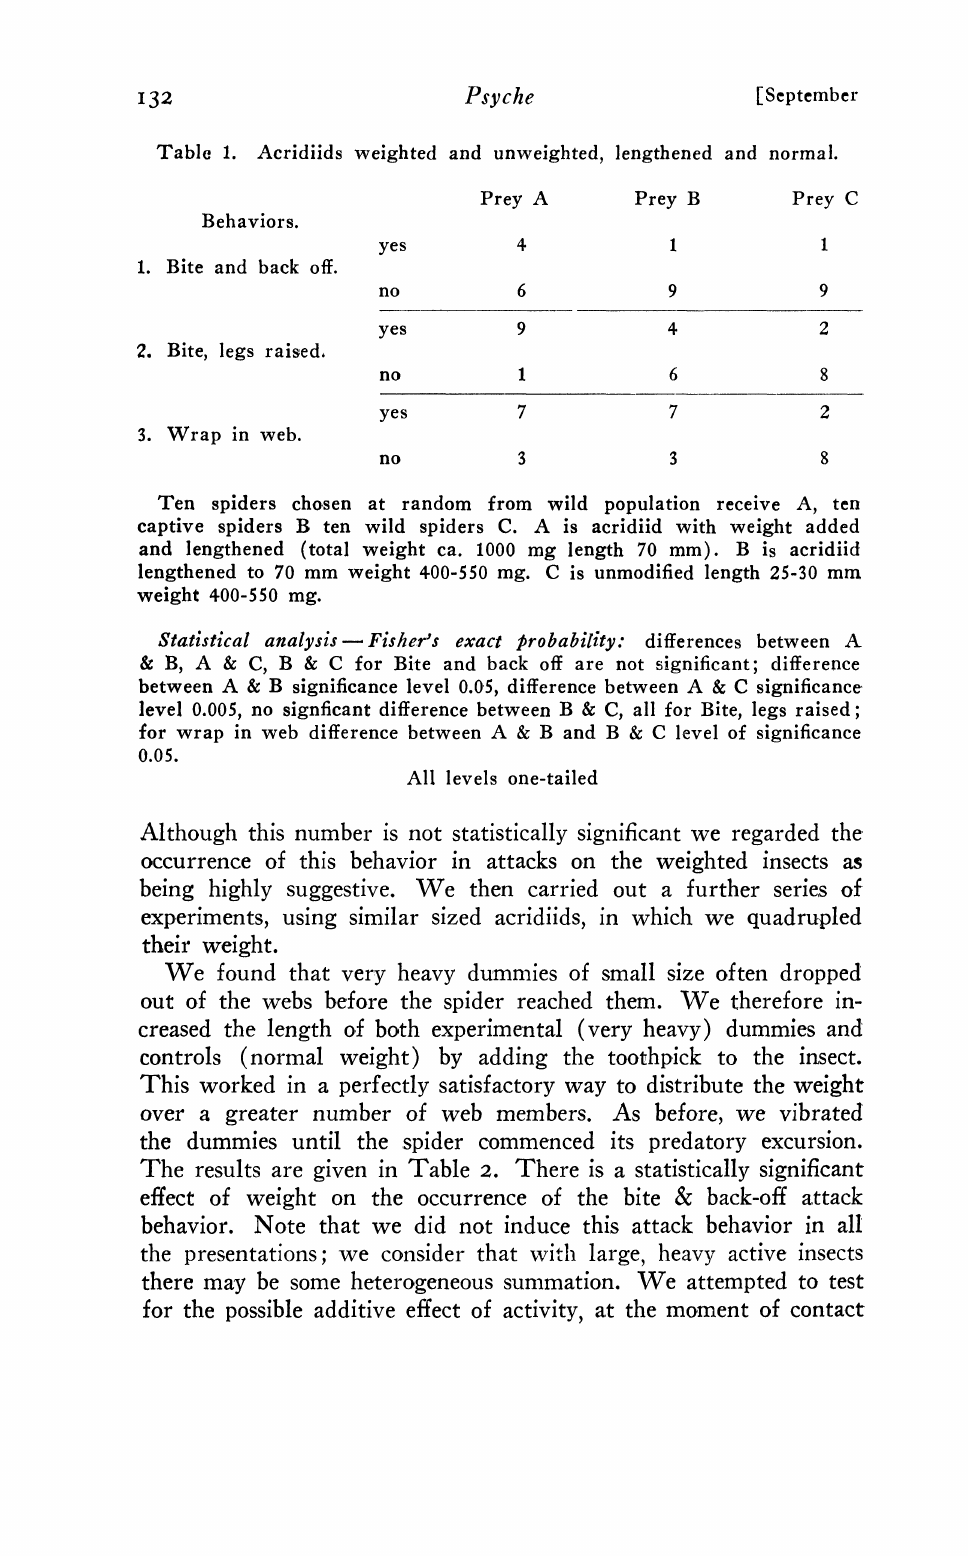
Table 1. Acridiids weighted and unweighted, lengthened and normal.